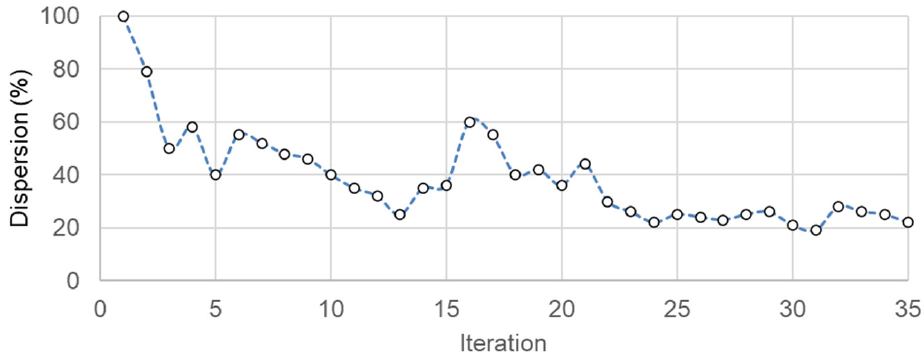
Figure 8. Dispersion rate with the iteration of PSO.